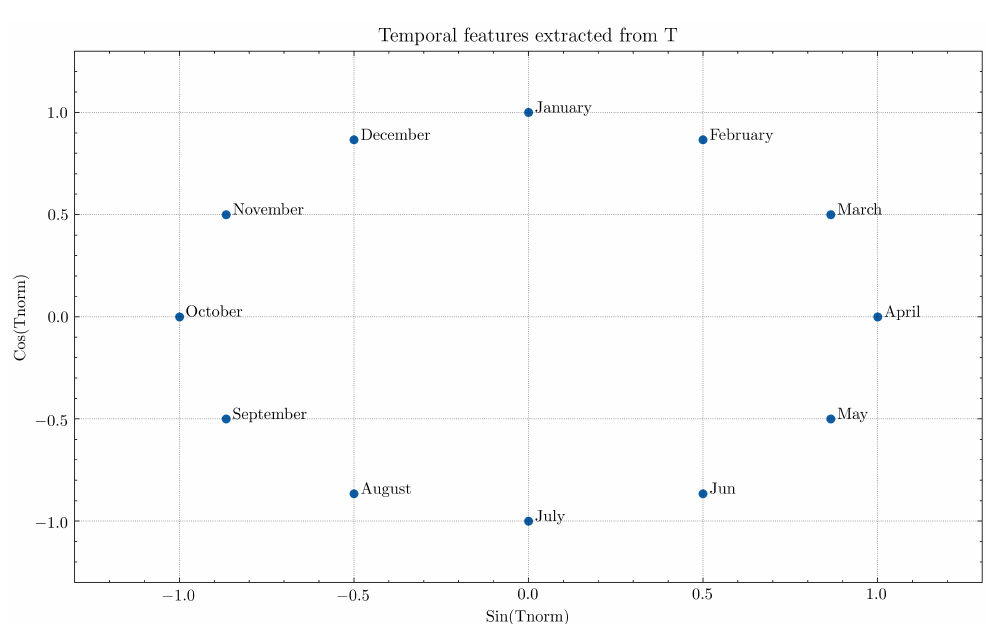
Figure 2. Temporal features